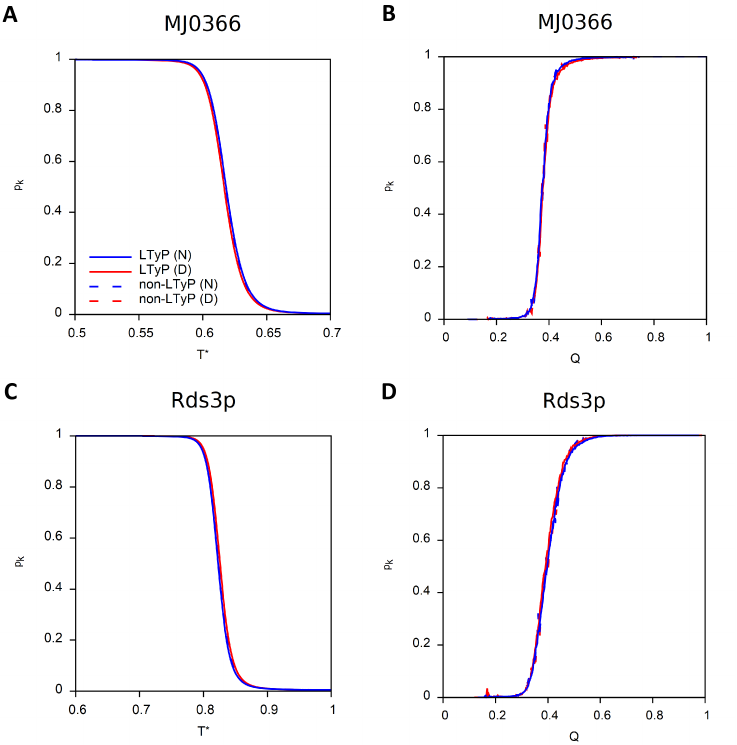
Figure 3. Knotting probability, p k , as function of reduced temperature and of Q . Simulations starting from native conformation (N) are colored blue and those starting from a denatured conformation (D) are colored red. Continuous lines correspond to LTyP simulations and dashed lines to non-LTyP simulations. ( A , B ) MJ0366 (PDB id: 2EFV). ( C , D ) Rds3p (PDB id: 2K0A).